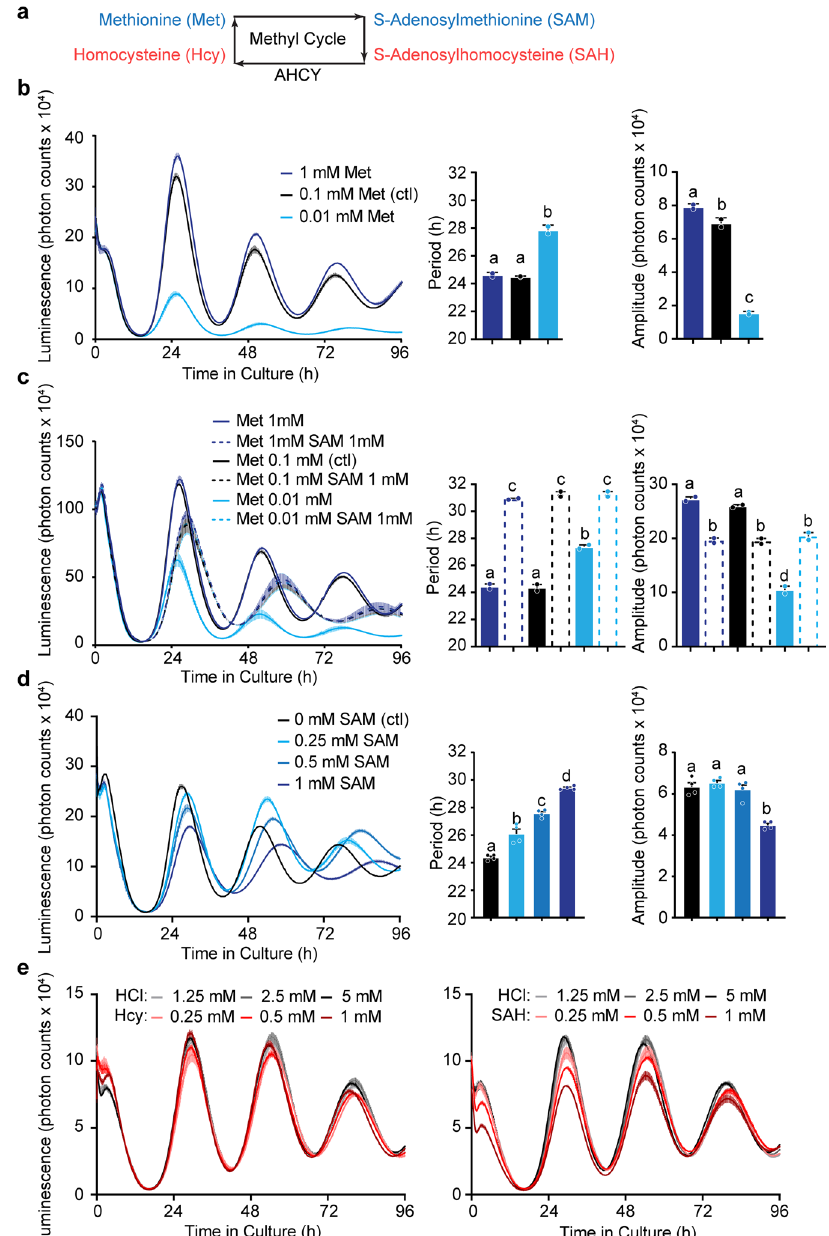
Fig. 1 Exogenous SAM lengthens the circadian period. a Simpli fi ed representation of the methyl cycle. b Low methionine, but not its excess, signi fi cantly lengthens the circadian clock period of PER2::LUC oscillations in immortalized mouse embryonic fi broblasts. c Partial rescue of the baseline and amplitude drop caused by low methionine with S -adenosylmethionine (SAM), but overriding effects of SAM on period length. d Concentration-dependent period lengthening by exogenous SAM. e Homocysteine (Hcy) and S-adenosylhomocysteine (SAH) do not lengthen the circadian period compared to the vehicle HCl (Hydrochloric acid). All data shown are mean + / − S.E.M. of 2 (b, 3c) or 4 (d) culture wells. Data shown as bar graphs analyzed by one-way ANOVA followed by Bonferroni multiple comparison test, a vs. b vs. c vs. d (labels at the top of each bar) at least p <